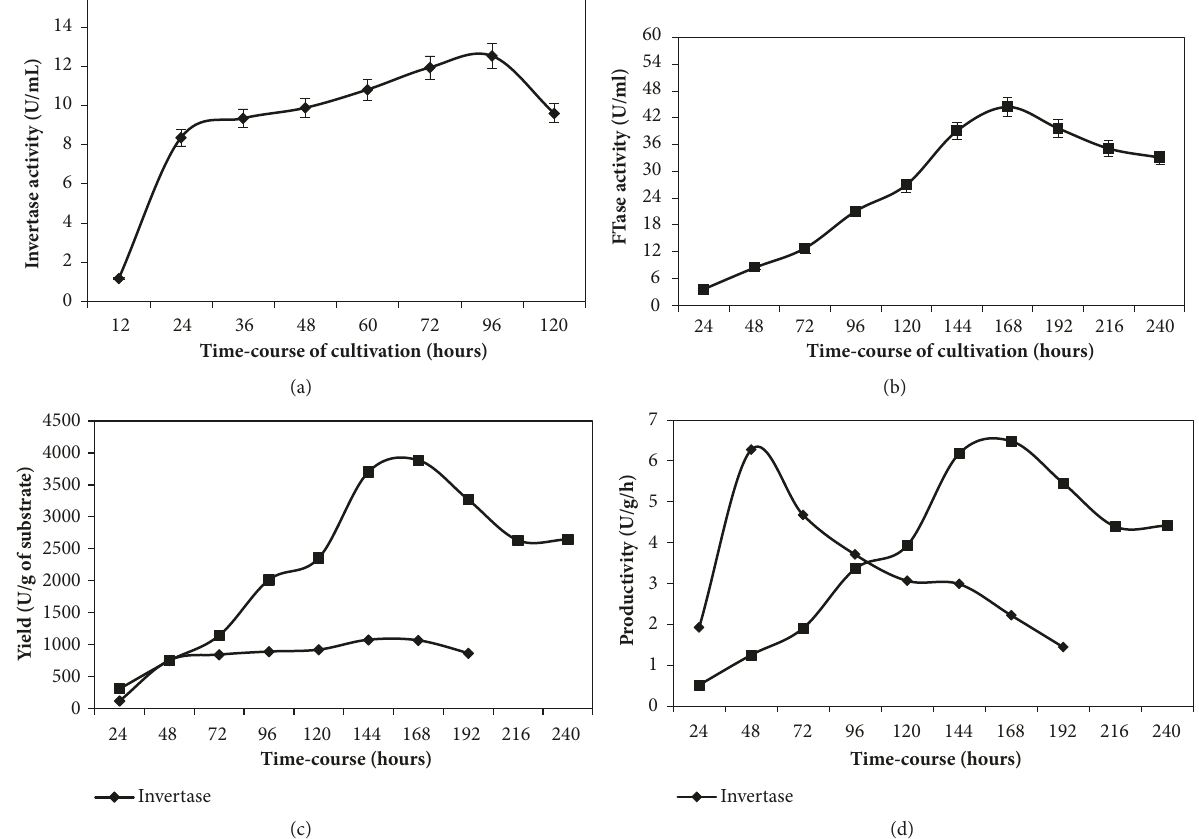
Figure 5: Time-course and fermentation parameters of invertase and 𝛽 -D-fructosyltransferase (FTase) produced by 𝐴 . carbonarius . PC-4. Legend: (a) invertase production; (b) FTase production; (c) yield of production for invertase and FTase; (d) productivity for invertase and FTase.Cultureconditions:invertaseproductionwascarriedoutusingpineapplecrown(1.0%,w/v),yeastextract(0.2%w/v);FTaseproduction was carried out using pineapple crown (1.0%, w/v) and soybean protein (0.2% w/v); cultures were carried out at 28 ∘ C, pH 6.0, and 180 rpm.